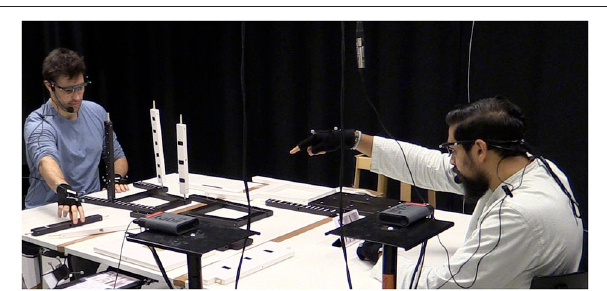
FIGURE 2 | In the corpus analysed in this article human speakers instructed each other how to assemble an IKEA stool. Behavioural data was collected during the